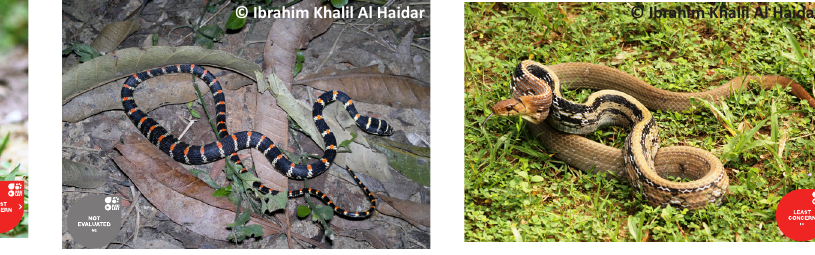
Image 5. Chrysopelea ornata Ornate Flying Snake